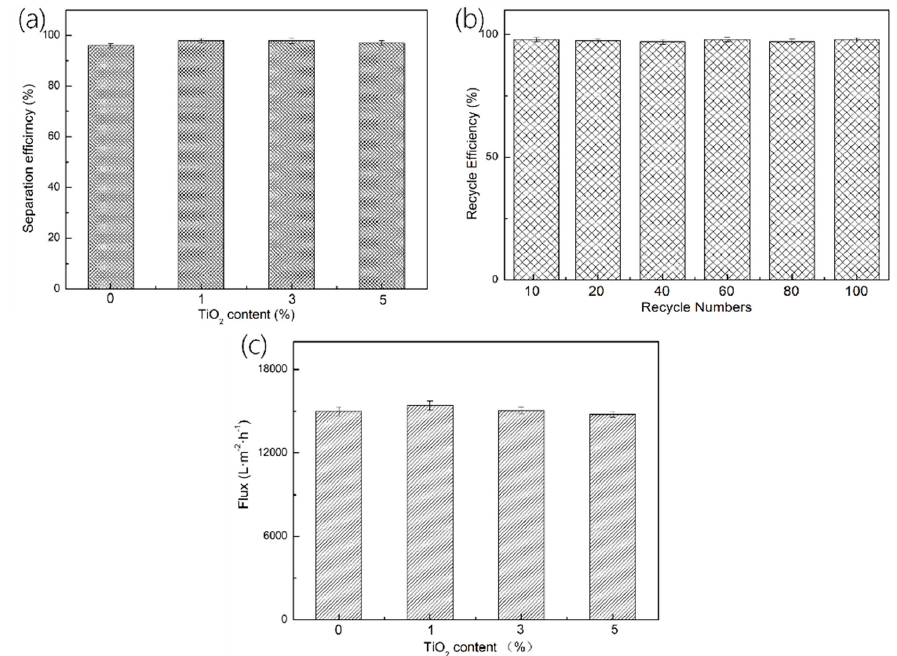
Figure 7. ( a ) Oil/water separation efficiency ( η s) of melt-blown membranes as related to TiO 2 content, ( b ) oil/water separation efficiency of M-PP/TiO 2 -3 as related to recycle numbers, and ( c ) gravity-driven kerosene flux of melt-blown membranes as related to TiO 2 content.